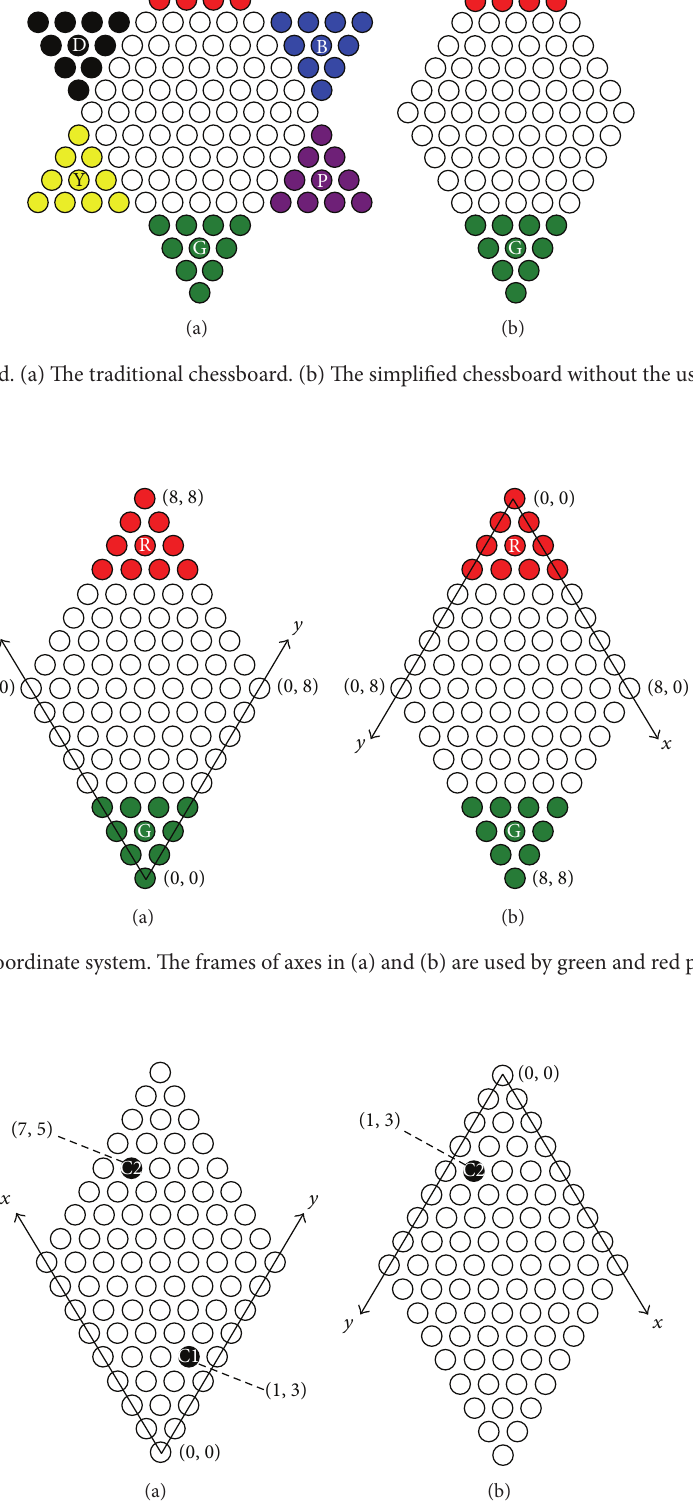
Figure 11: Every checker has two coordinates due to different frames of axes. For example, checkers C1 in (a) and C2 in (b) have the same coordinate. The two coordinates of checker C2 are (7, 5) and (1, 3),